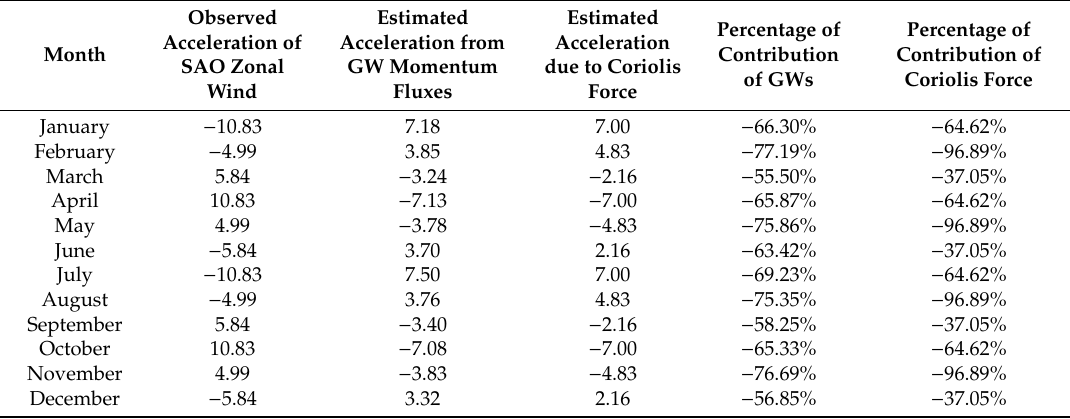
Figure 6. The observed and estimated acceleration of SAO zonal wind. Table 1. Percentage of the contribution of gravity waves (GWs) and the Coriolis force to the SAO zonal wind.